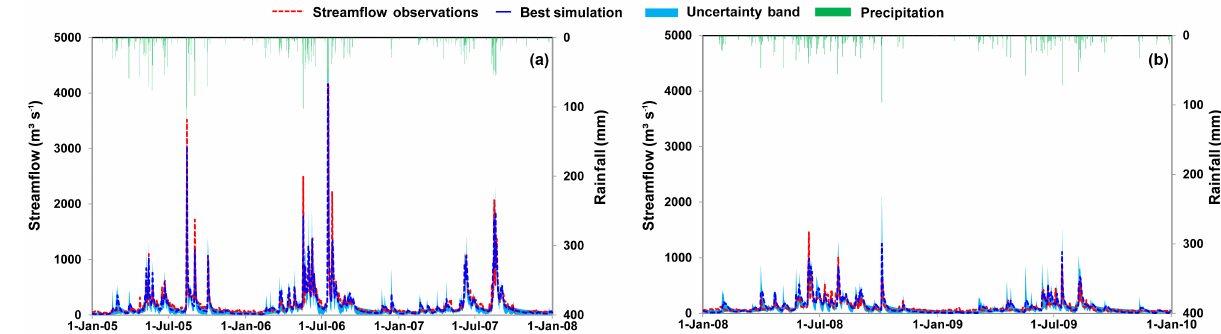
Figure 2. Simulated streamflow for the benchmark calibration of the Jinjiang Basin in both the calibration (2005–2007) and validation (2008–2009) periods.